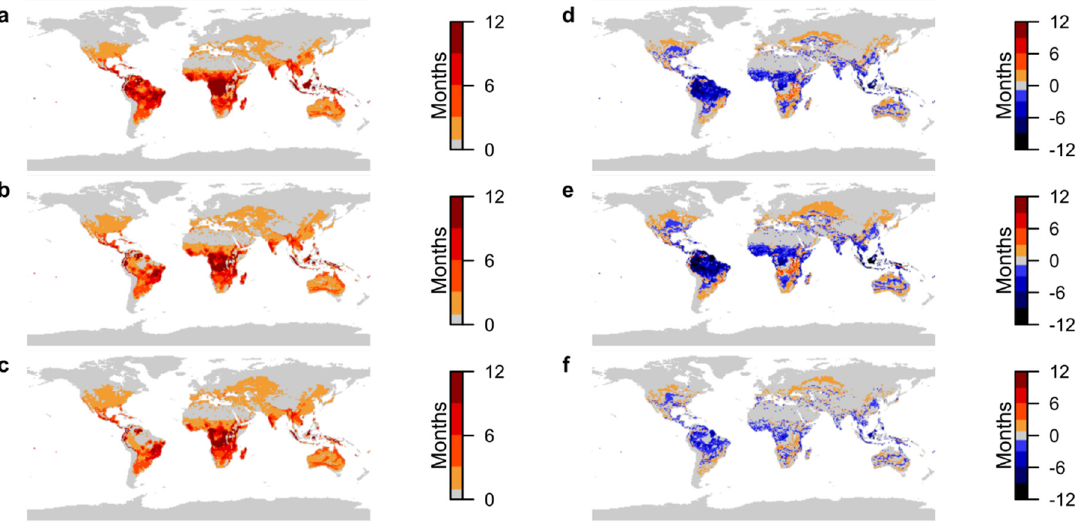
Figure 1. Projections of transmission suitability for malaria. ( a ) Number of months of transmission suitability in present day; ( b ) number of months of transmission suitability in 2050 under SSP1-2.6; ( c ) number of months of transmission suitability in 2050 under SSP5-8.5; ( d ) change in number of months of transmission suitability from present day to 2050 under SSP1-2.6; ( e ) change in number of months of transmission suitability from present day to 2050 under SSP5-8.5; ( f ) difference in number of months of transmission suitability in 2050 between SSP5-8.5 and SSP1-2.6. For ( a – c ), colour-bar scales are set so that increasing intensity of red depicts areas where transmission suitability is marginal (1–3 months), moderate (4–6 months), seasonal (7–9 months) and endemic (10–12 months). For ( d – f ), colour-bar scales are similarly grouped, with increasing intensity of red depicting increases in transmission suitability of 1–3 months, 4–6 months, 7–9 months and 10–12 months, and increasing intensity of blue depicting the equivalent decreases. Only areas where differences are statistically significant at the 95% confidence level are plotted.